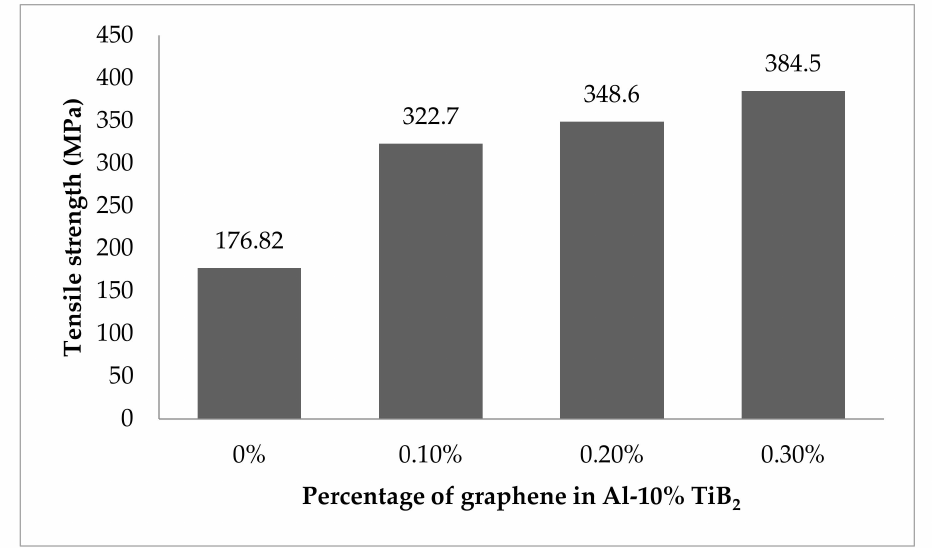
Figure 10. Tensile strength at high